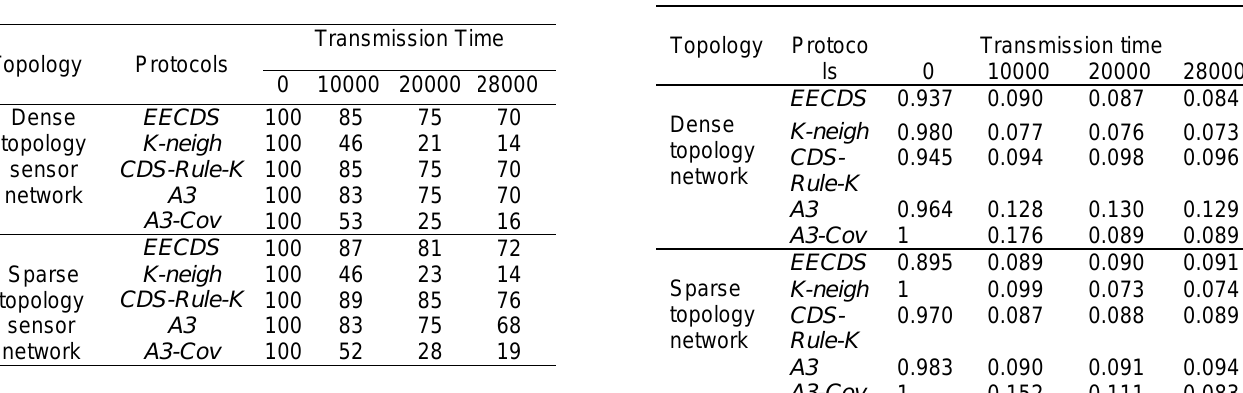
Table 7. Experiment 3: Covered area for